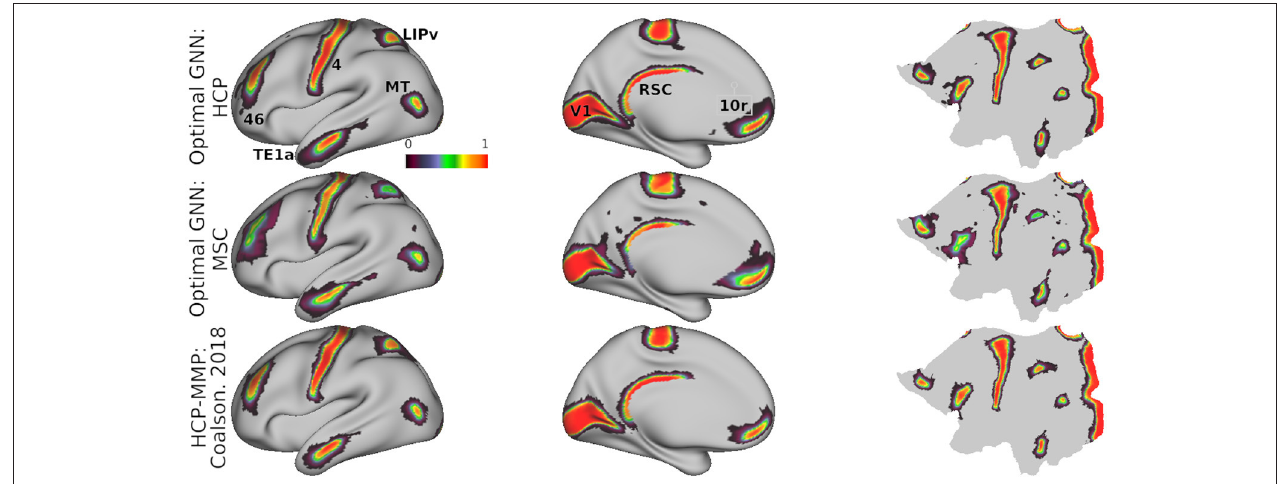
FIGURE 5 | Mean model probabilities for a subset of cortical areas for the HCP (top) and MSC (middle) datasets computed using the optimal model, and the MMP binary class probabilities from Glasser et al. (2016) and Coalson et al. (2018) (bottom) . Probabilistic maps are illustrated for areas V1, 46, TE1a, LIPv, MT, RSC, and 10r. These maps are thresholded at a minimum probability value of 0.005, the probability of randomly assigning a vertex to one of the 180 cortical areas.